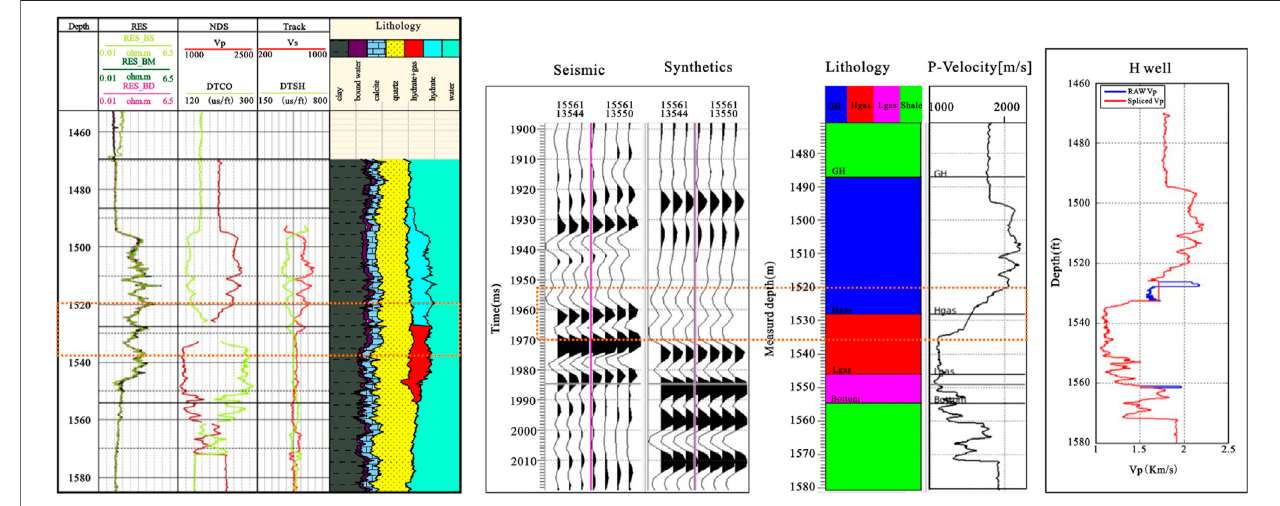
FIGURE 15 | Diagram of calibrating downhole seismic in Well H (before optimization).